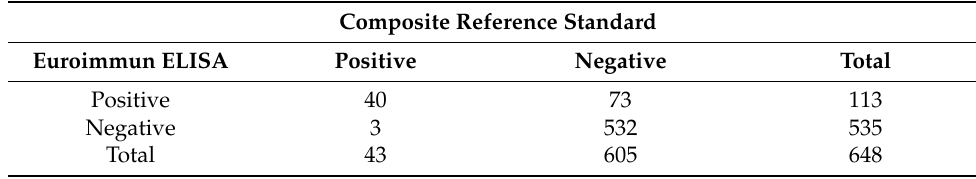
Table 1. Proportion of positive and negative results to the Euroimmun ELISA against the composite reference standard